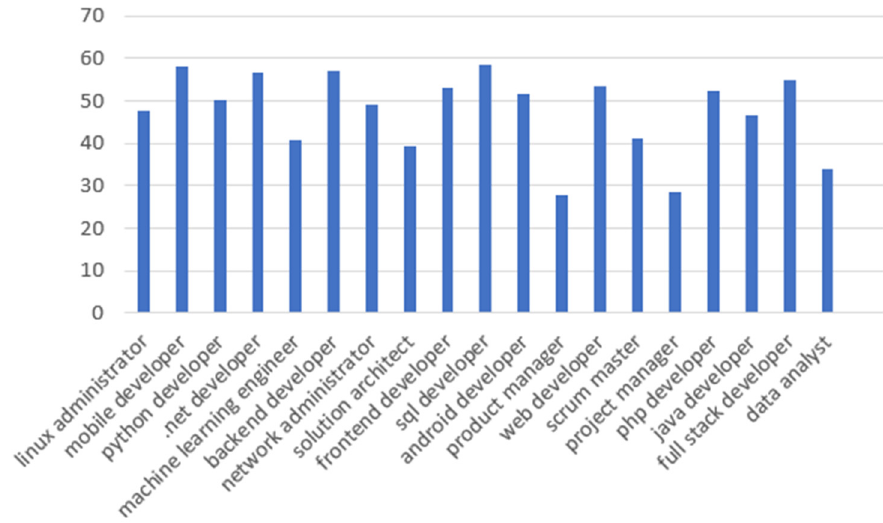
Figure 19. Success rate of finding job requirements in individual job positions—machine learning with marking lists approach.